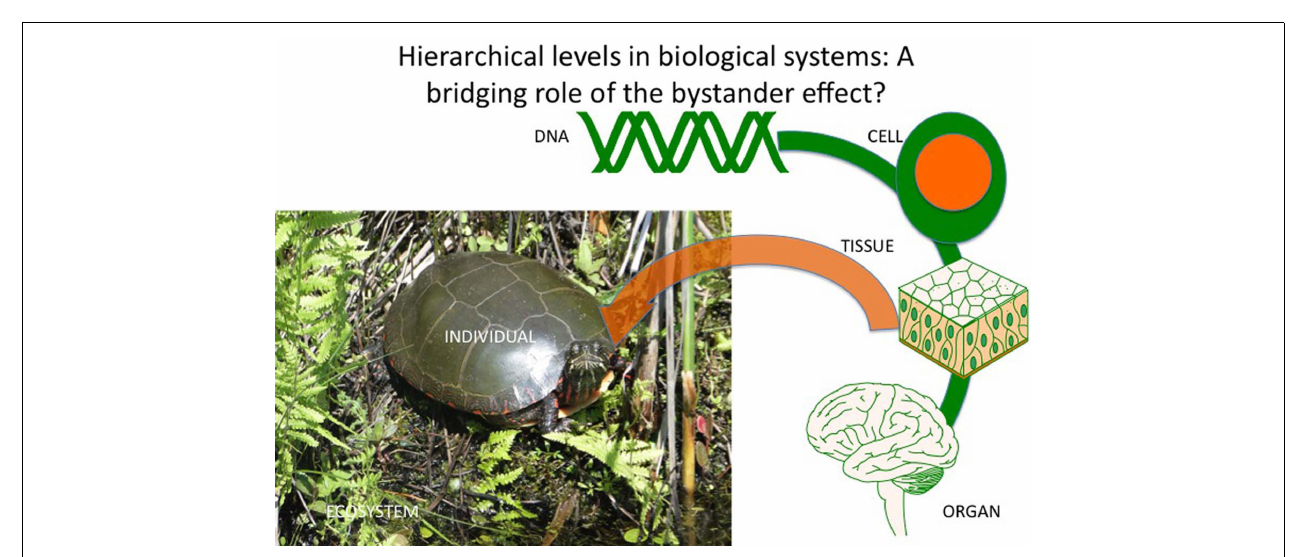
FIGURE 3 | Hierarchical levels in biological systems indicating a coordinating role for stress-induced bystander